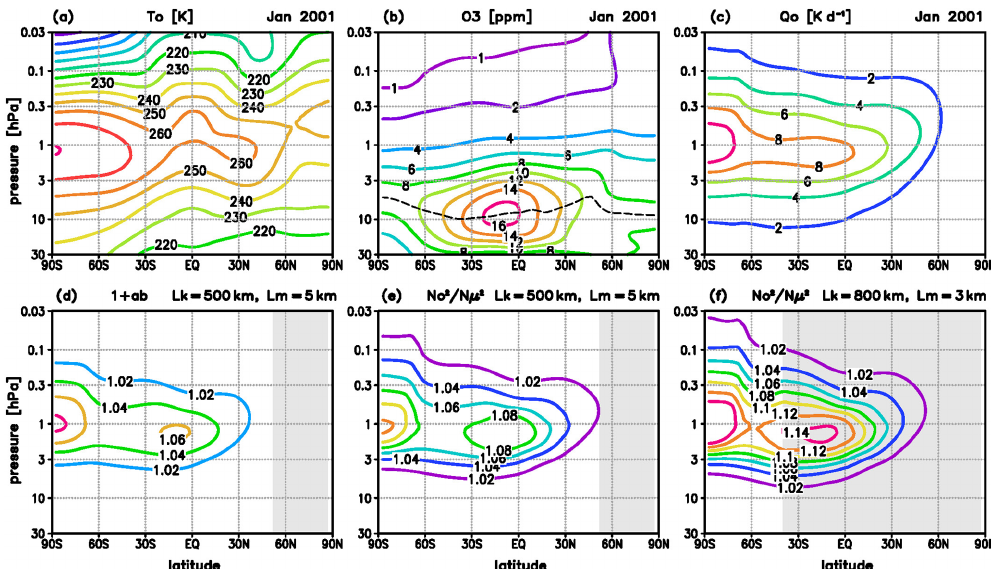
Figure 1. (a–c) Zonal and monthly mean background, (a) temperature T 0 , (b) ozone mixing ratio O 3 (the dashed line denotes where ∂ O 3 /∂z = 0), and (c) ozone heating rate Q 0 , January 2001, extracted from a simulation with the circulation and chemistry model HAMMO- /N 2 µ for a GW with horizontal and vertical wavelengths L k = 500km and L m = 5km, NIA; (d–f) amplification factors, (d) 1 + ab and (e) N 2 0 /N 2 µ for a GW with L k = 800km and L m = 3km; shaded areas denote the latitudes where the amplification is limited by the length and (f) N 2 0 of daylight ( τ i > τ day